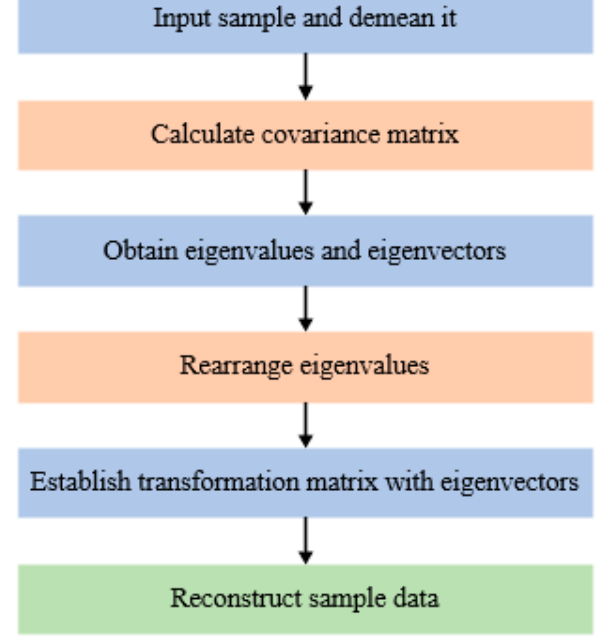
Figure 1. Flowchart of dimensionality reduction using the K–L transform.